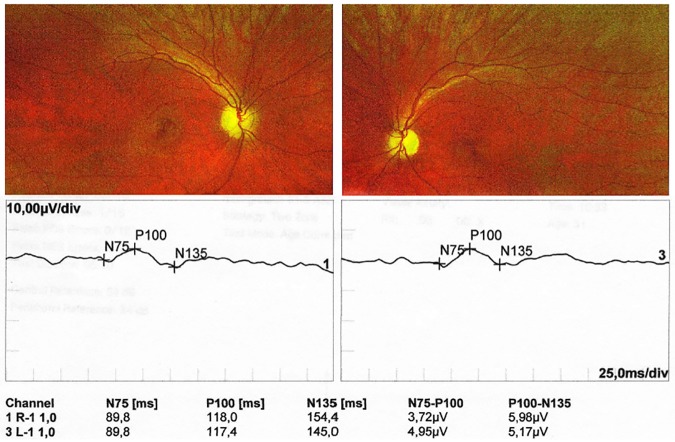
Characteristic features on ophthalmological evaluation in the proband from family A.Fundus examination showed bilateral temporal pallor of the optic disc. PVEP presented a reduced amplitude and delayed latency of P100 wave. Components of PVEP, N75, P100 and N135, indicate polarity (negative or positive) and absolute latencies (msec) of the peaks waveforms. Right panel—left eye, left panel—right eye.